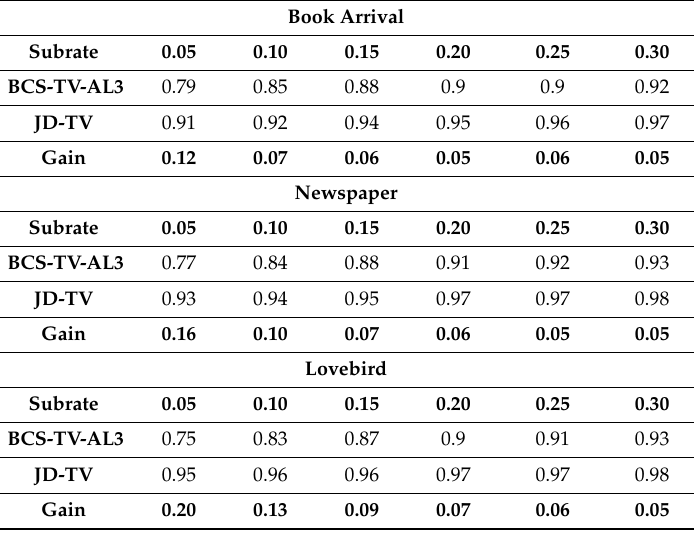
Table 6. Average SSIM evaluation of proposed JD-TV scheme and the independent BCS-TV-AL3 for di ff erent HD at various subrates having GoP =